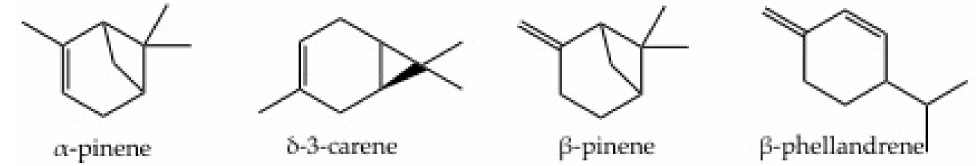
Figure 7. Main secondary metabolites produced by Pinus mugo .